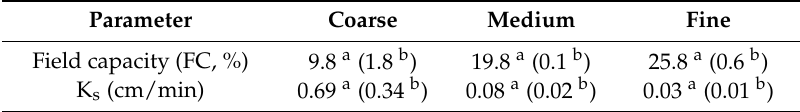
Table 3. Estimated parameter values for the relative effective porosity model